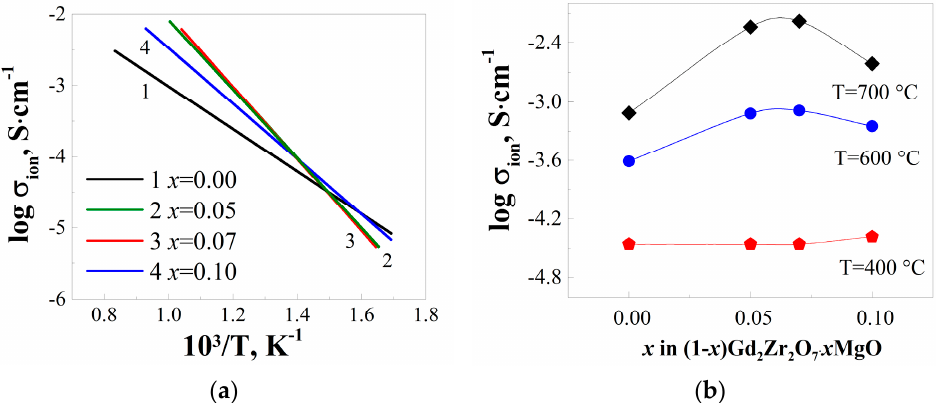
Figure 9. Temperature dependence of ionic conductivity ( a ). Dependence of ionic conductivity on x in (1- x )Gd 2 Zr 2 O 7 · x MgO at 600 °C ( b ).